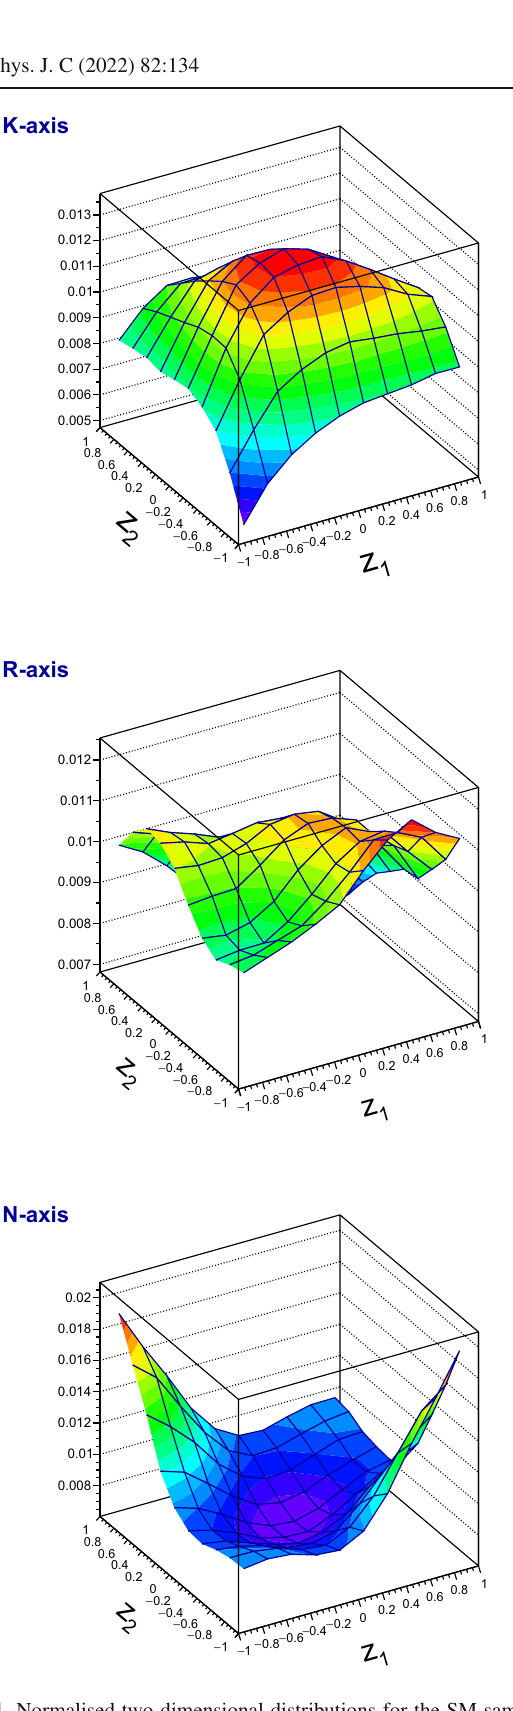
Fig. 4 Normalised two-dimensional distributions for the SM sample using the K (top), R (middle) and N (bottom) sets of axes